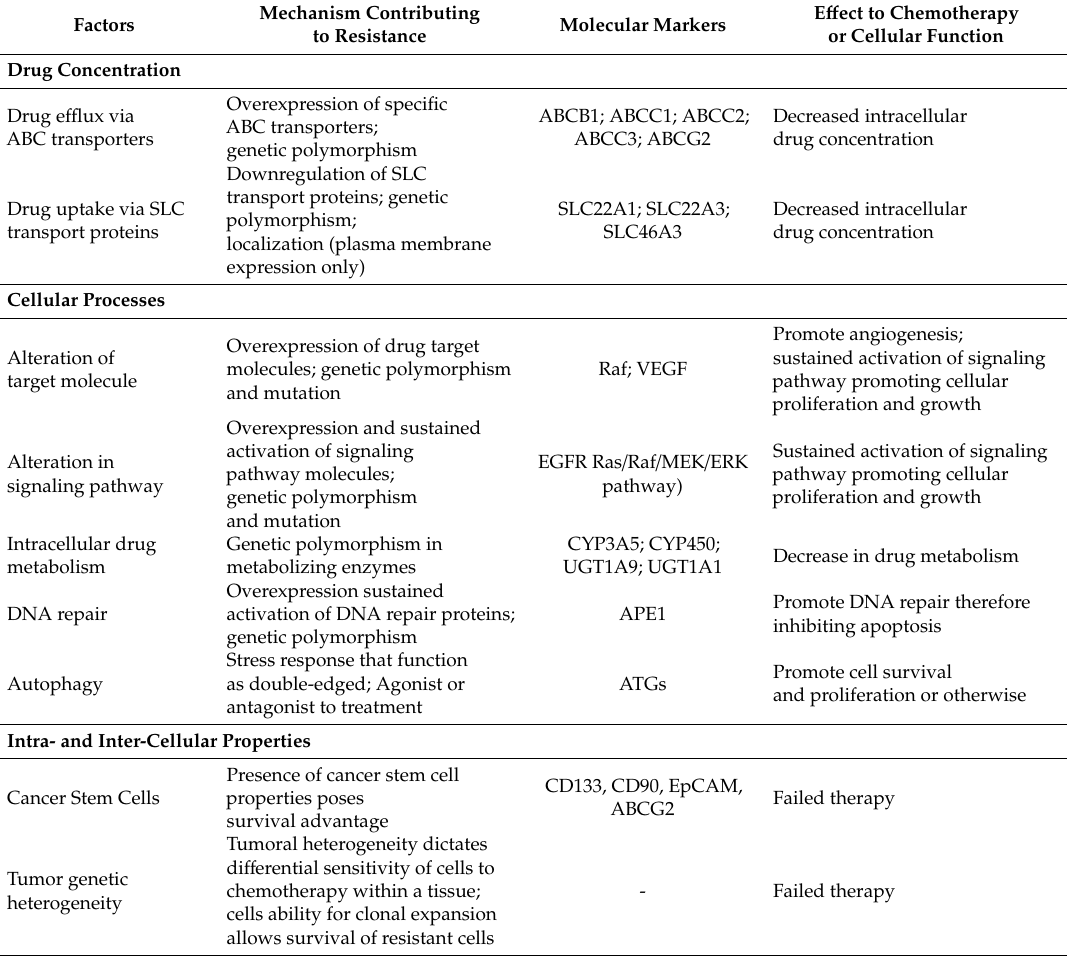
Table 1. Mechanisms of resistance against sorafenib in